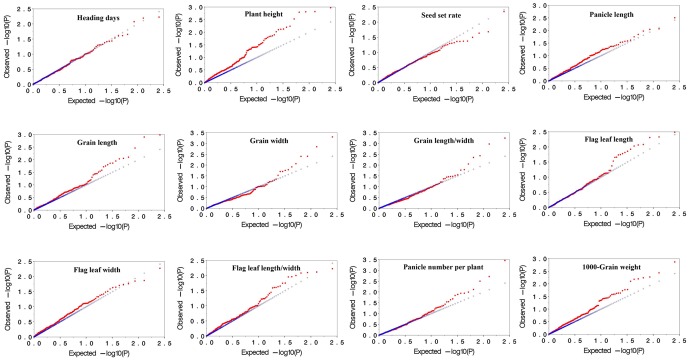
Plots of observed versus expected P-values using MLM (Q+K) model for 12 agronomic traits in 2008.The blue symbol the represents expected P-values, and the red symbol represents the observed P-values.